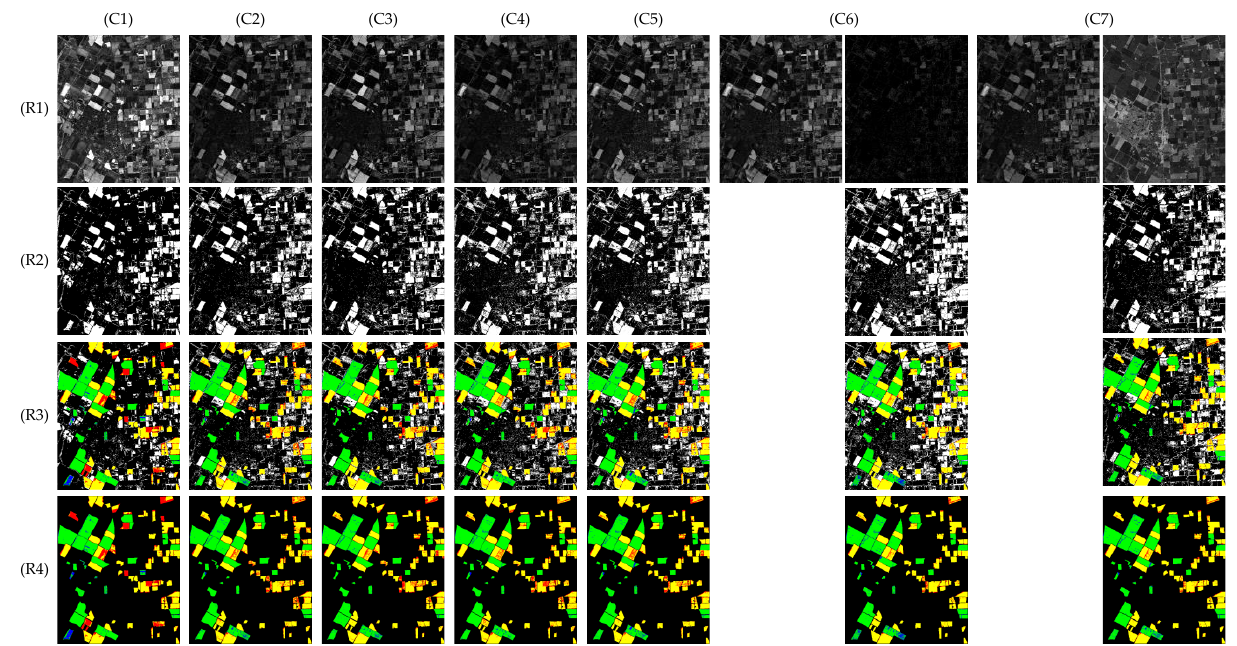
Figure 11. Visualization of comparison on dataset ‘Bay Area’. ( C1 ) CVA, ( C2 ) CD-FCN, ( C3 ) DSFA, ( C4 ) CD-USNet, ( C5 ) CD-CSNet, ( C6 ) CD-SDN-AM, ( C7 ) CD-SDN-AL. ( R1 ) CPM, ( R2 ) BCM, ( R3 ) F-HSM, ( R4 ) K-HSM.